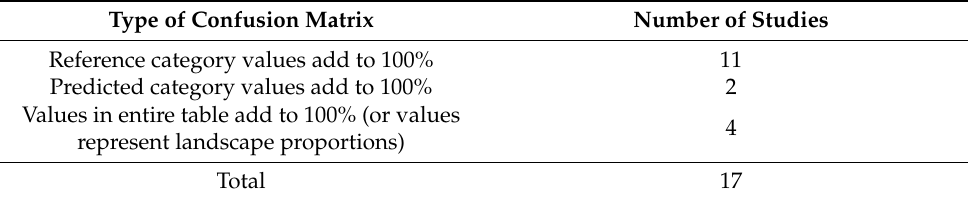
Table 5. Type of confusion matrix presented in the surveyed literature.